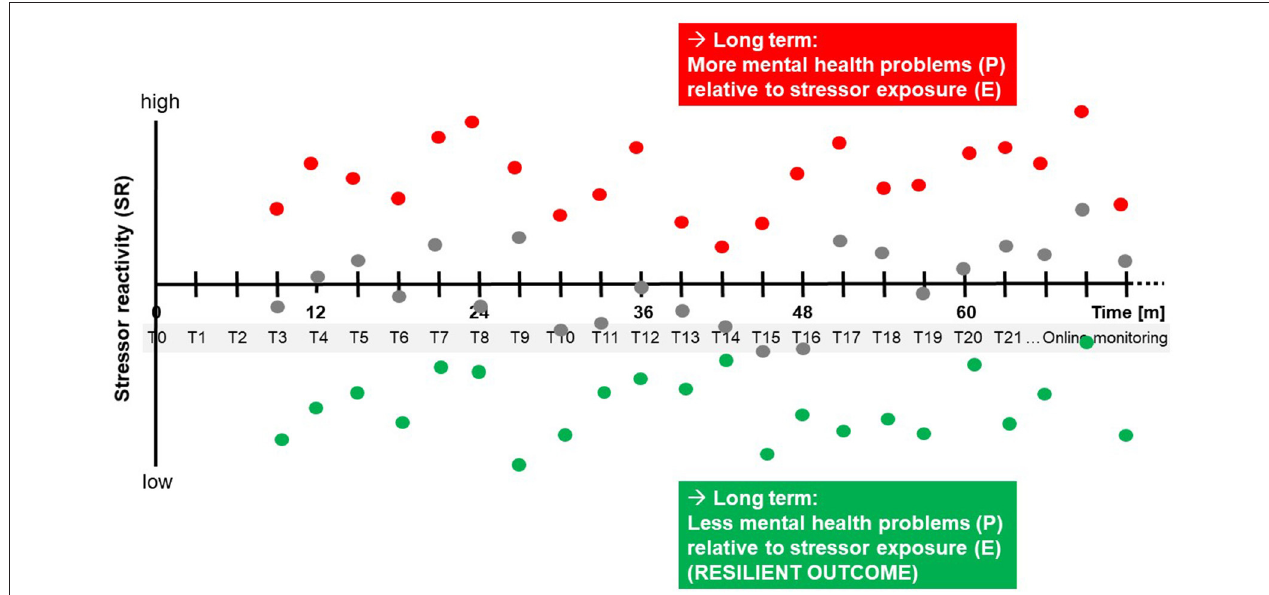
FIGURE 5 | Hypothetical time courses of stressor reactivity. Three hypothetical study subjects with consistently high (red), average (gray), and low (green) stressor reactivity (SR), determined in sliding windows of three consecutive monitoring time points (T1–T3; T2–T4; T3–T5; …), are shown. In the long run, consistently lower-than-normal stressor reactivity leads to fewer mental health problems P relative to individual stressor exposure E, that is, to a more resilient outcome.